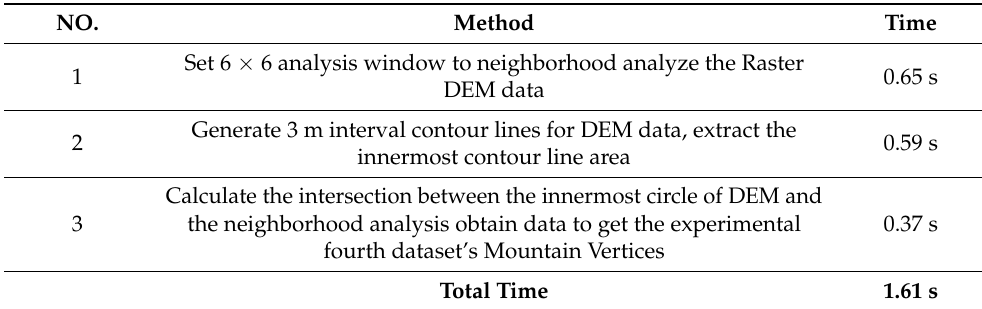
Table 15. The time spent in extracting mountain vertices for the fourth dataset using the Contour Line and Neighborhood Analysis Overlay Method.